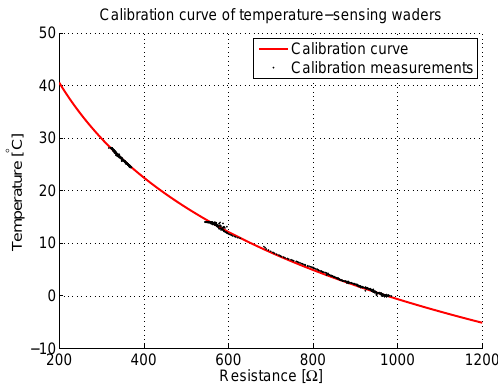
Figure 3. Results of the calibration experiment, showing the resis- tance of the waders ( x axis) versus the temperature of the water as measured by TidBits ( y axis). The red line is the fitted Steinhart– Hart